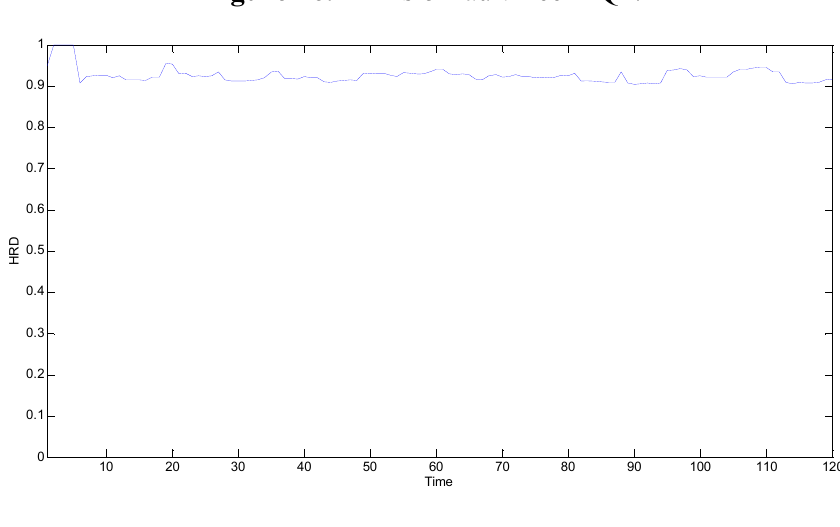
Figure 16. HRD s of fault free